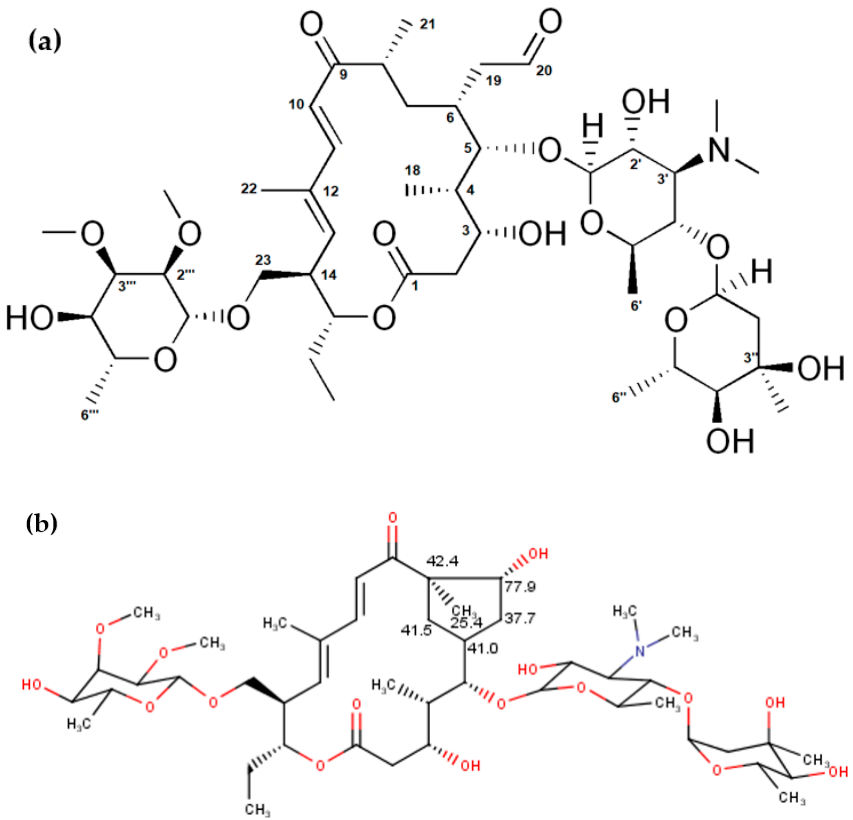
Figure 1. ( a ) Structure of tylosin A and ( b ) predicted 13 C NMR chemical shifts characteristic for the structure of tylosin aldol.